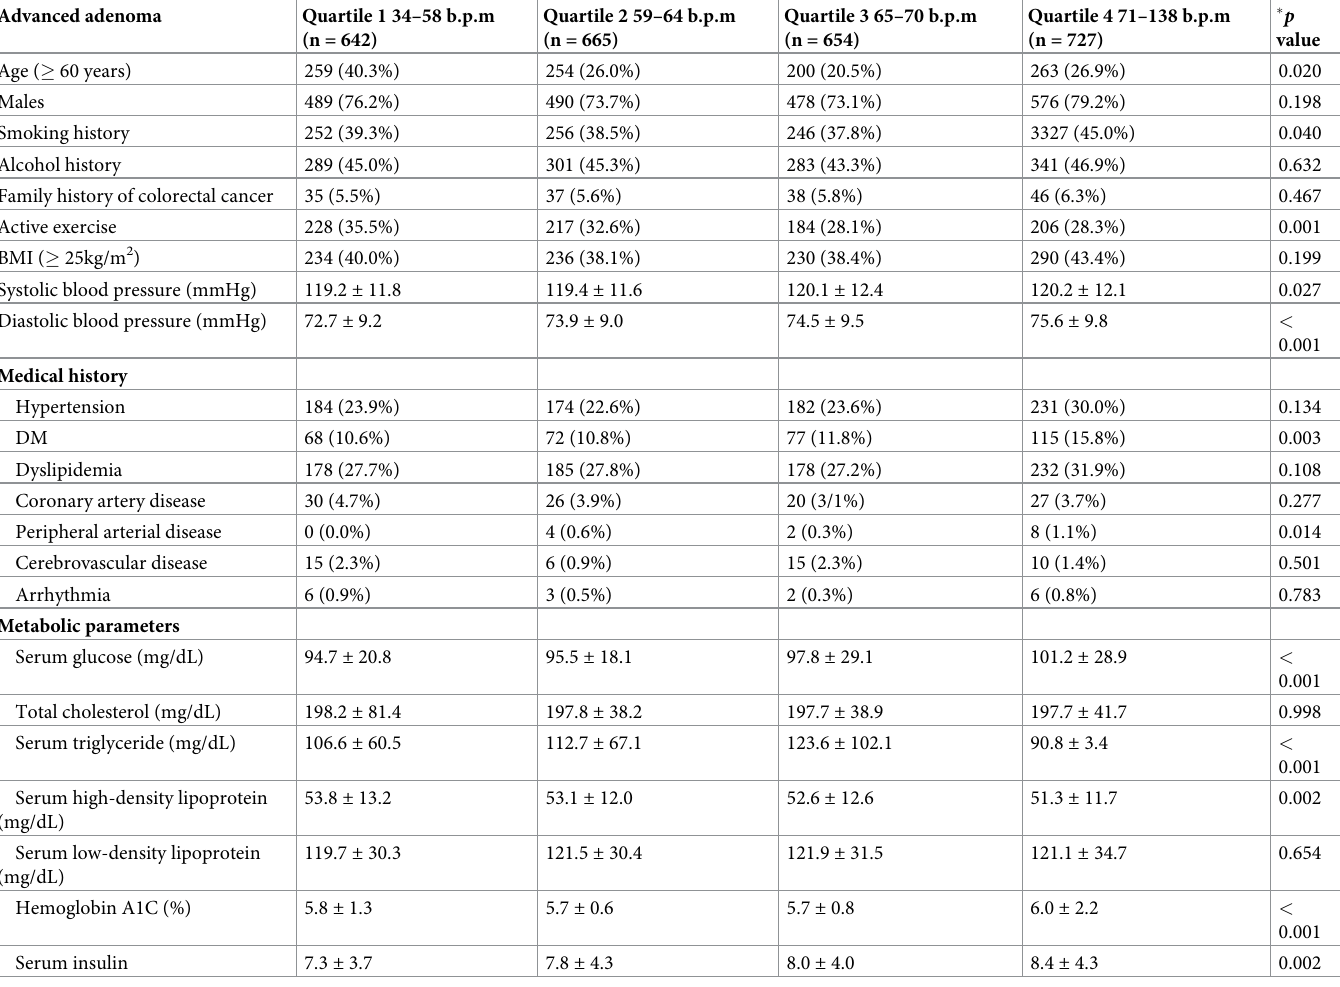
Table 2. Baseline characteristics of the study participants according to resting heart rates quartiles.